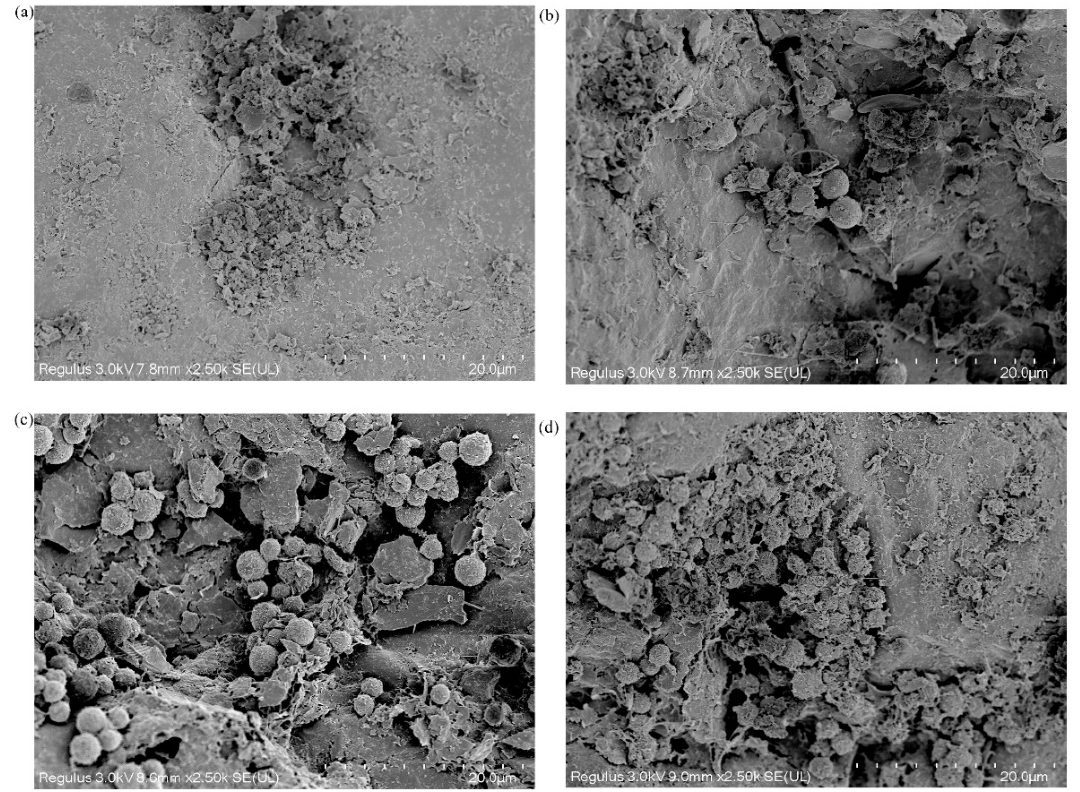
Figure 4. SEM micrographs of the substrates at the end of experiment. ( a ) C–CW, ( b ) K–CW, ( c ) M–CW and ( d ) PS–CW.